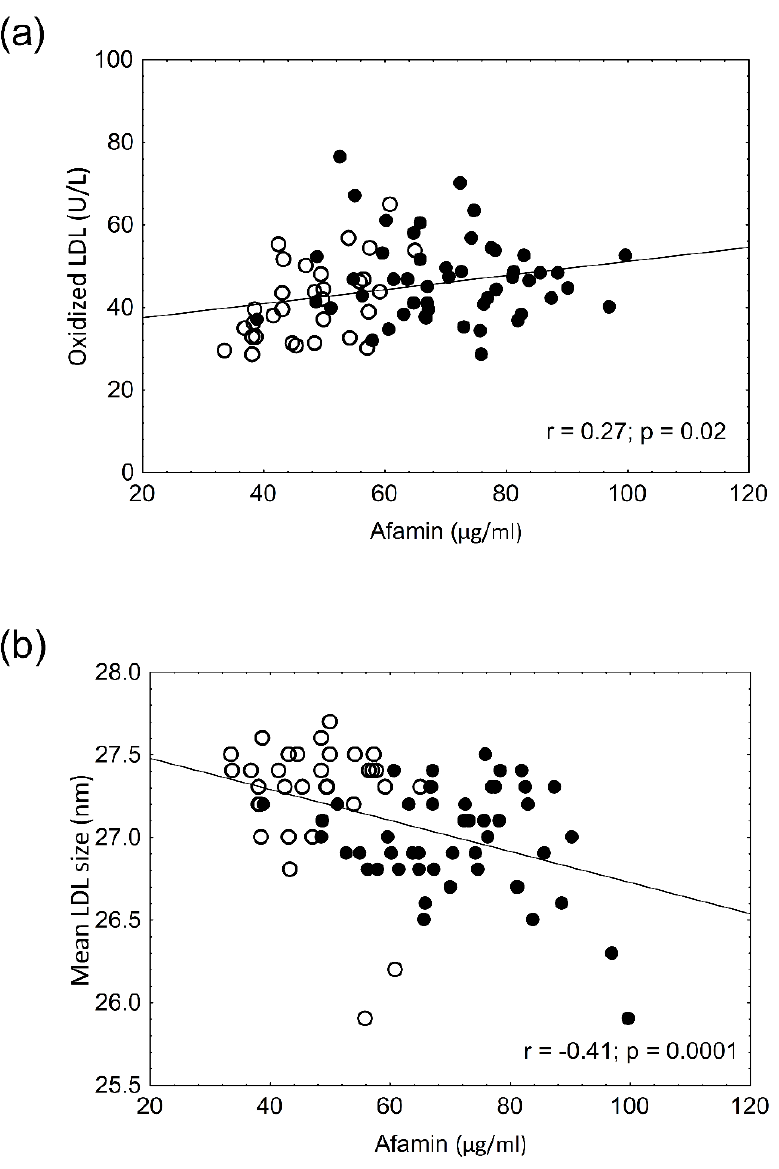
Figure 1. Correlations between afamin and oxidized LDL levels ( a ) and between afamin levels and mean LDL size ( b ) in the study populations (● obese non-diabetic patients vs. ○ lean controls).